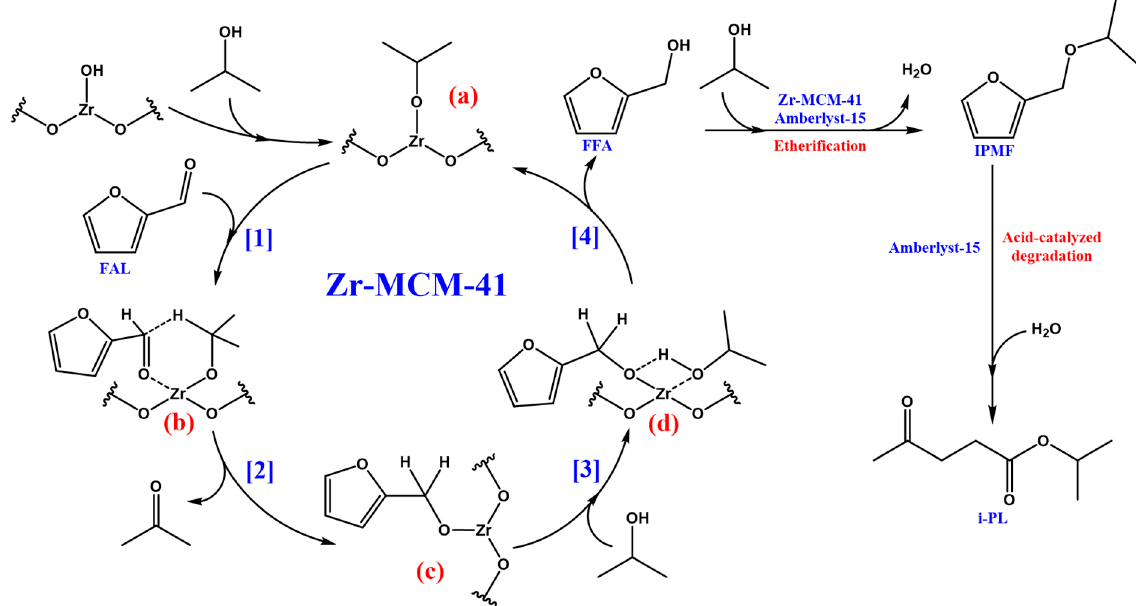
Scheme 9. Proposed mechanism for isopropyl levulinate (i-PL) synthesis from furfural using isopropanol as the hydrogen donor by combing Zr-MCM-41and Amberlyst-15.